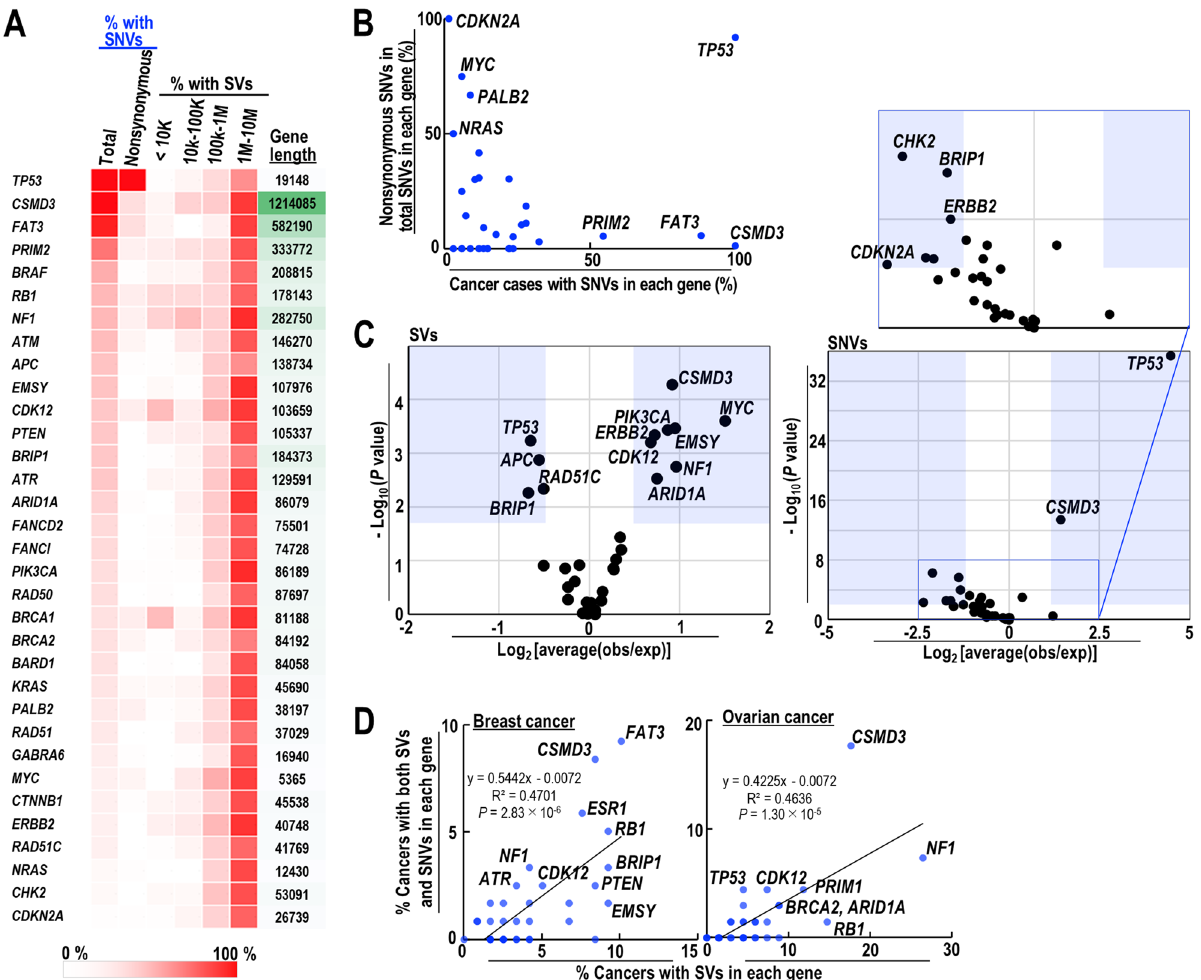
Figure 7. SV-associated induction of SNVs in genes frequently mutated in ovarian cancer. ( A ) Mutation status of genes frequently mutated in ovarian cancer was analyzed. SV status within and outside the genes is shown alongside gene size, in which regions outside genes are analyzed within 10 kb, 10–100 kb, 100 kb–1 Mb, and 1–10 Mb. ( B ) Cancer cases were analyzed by plotting the SNVs in each gene against nonsynonymous SNVs (as a percentage of total SNVs) in each gene. ( C ) Relative SV and SNV statuses of each gene is depicted in volcano plots. ( D ) The number of individual cancer cases harboring both SVs and SNVs was plotted against the number of SVs in each gene (for both breast and ovarian cancers). A two-tailed t -test was used for statistical